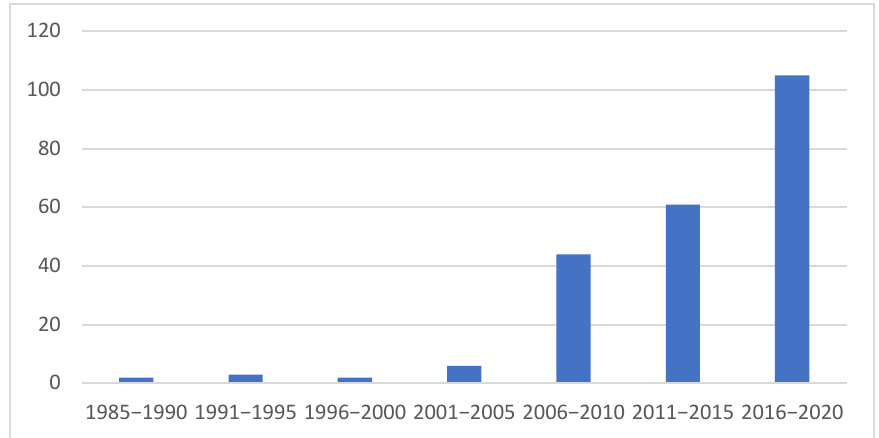
Figure 3. Total publications every 5 years (1985 –2020). Author’s elaboration from record count by WOS.